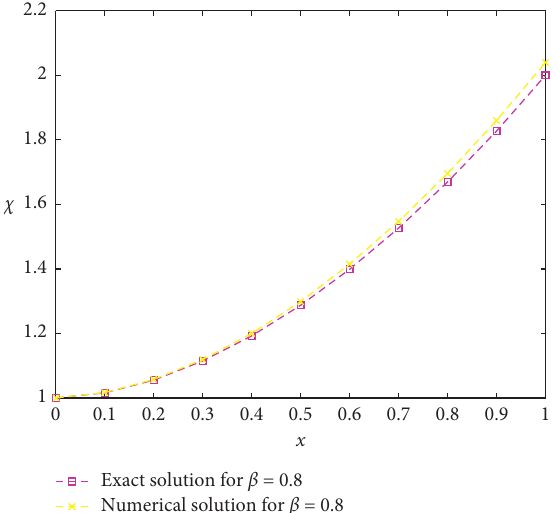
Figure 8: The numerical and exact solutions for fractional order β � 0 . 8.